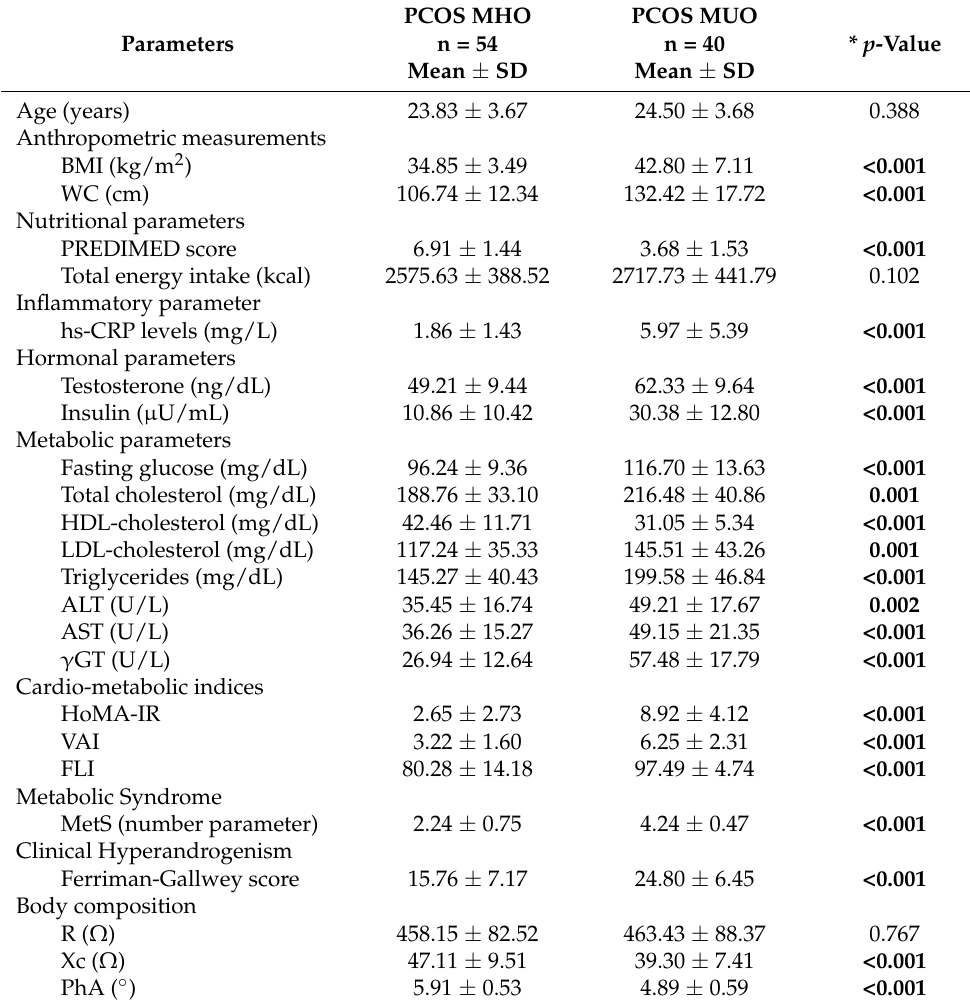
Table 3. Differences in study parameters according to metabolically healthy versus metabolically